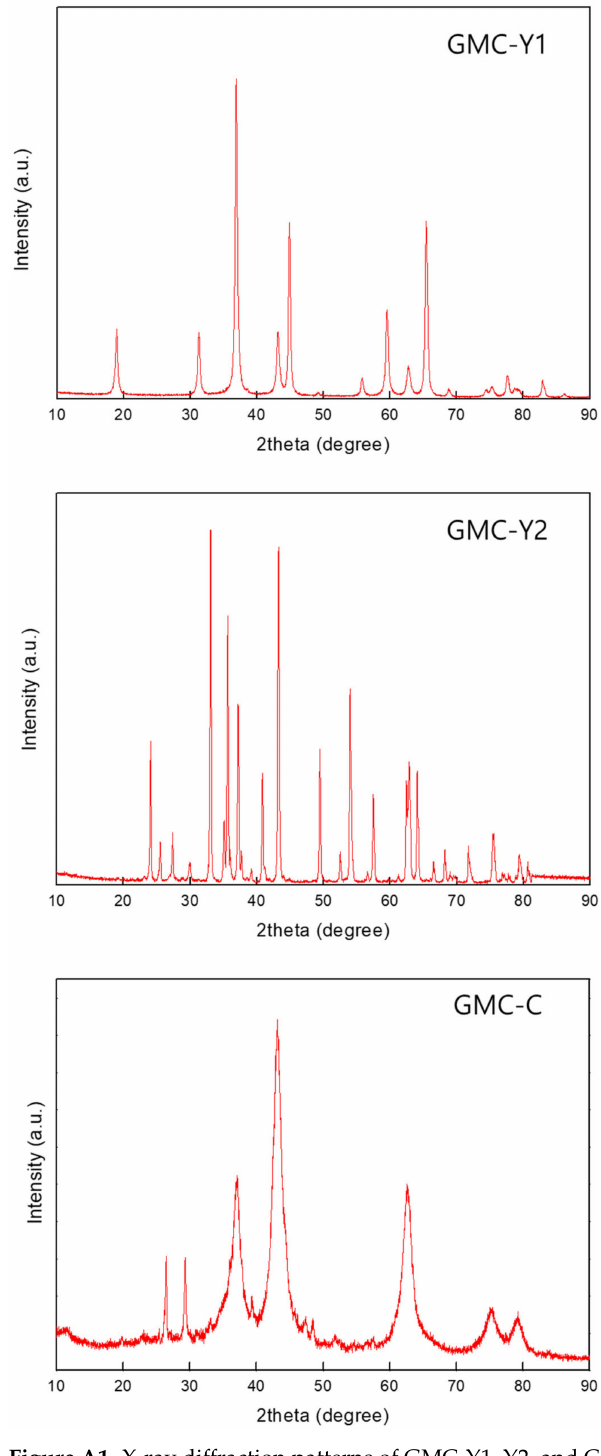
Figure A1. X-ray diffraction patterns of GMC-Y1, Y2, and C